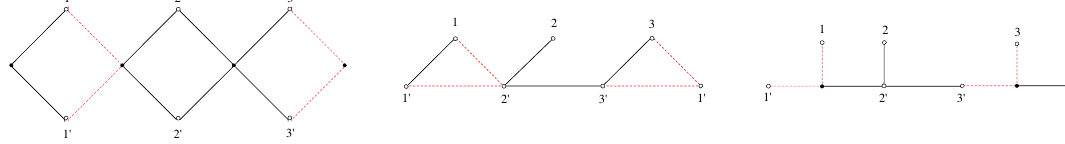
Figure 22 . Left: integral kernel of the transfer matrix operator t ( a ) ( u ) for a spin chain of length ˙ L = 3 , for scalar auxiliary space ‘ a = ‘ a = 0 and inhomogeneous representation in physical spaces: scalar (1 , 0 , 0) or Weyl fermion (3 / 2 , 0 , 1) , with inhomogeinities θ = − ∆ / 2 according to (4.10). Center: reduction of the kernel at the point u → − 1 / 2 . Right: by star-triangle duality the reduced kernel can be written as the graph building operator for a planar Feynman diagram wrapped onto a cylinder, whose topology mixes square-lattice and Yukawa hexagonal